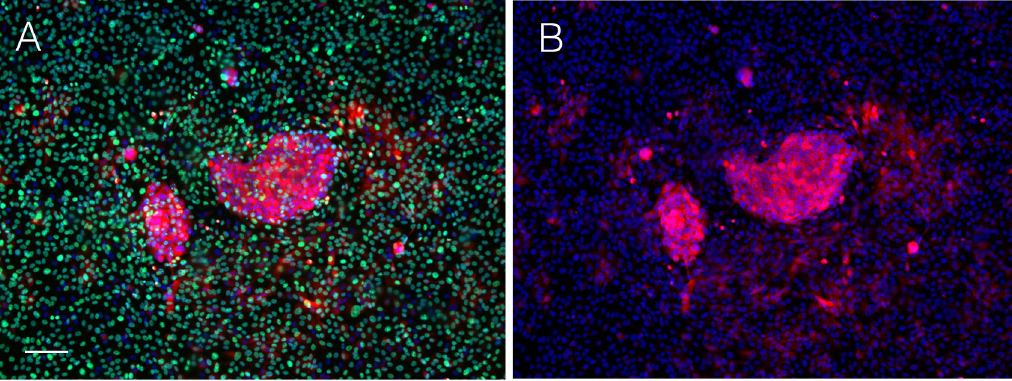
Fig 5. Detection of phosphorylation of ERK1/2. ACT1 cell clusters were co-cultured with GFP-NTECs for 5 days, fixed with formaldehyde, and stained with anti-phosphorylated ERK1/2 antibody (red) and anti-Ki-67 antibody (green). (A) Merged image. (B) Red fluorescence image showing regional phosphorylation of ERK1/2 in NTECs. The bar indicates 100 μ m.